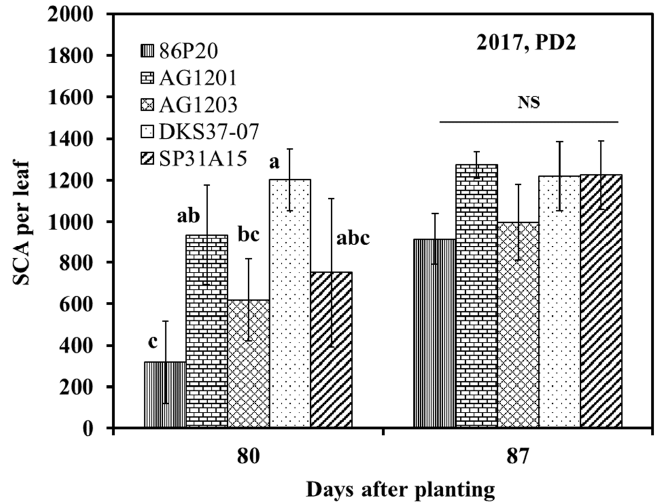
Figure 2. Average sugarcane aphid populations in each hybrid for 2017, PD2 grain sorghum. For 80 days after planting, means with the same letters are not significant at p = 0.05. NS: not signifi- cant ( p > 0.05).